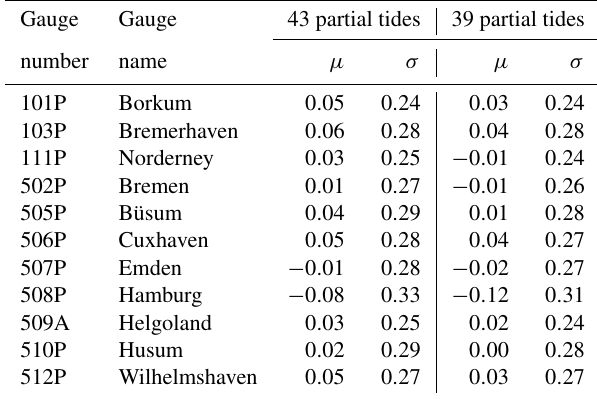
Table 6. Residuals of predicted and observed heights of high and low water: mean µ and standard deviation σ in